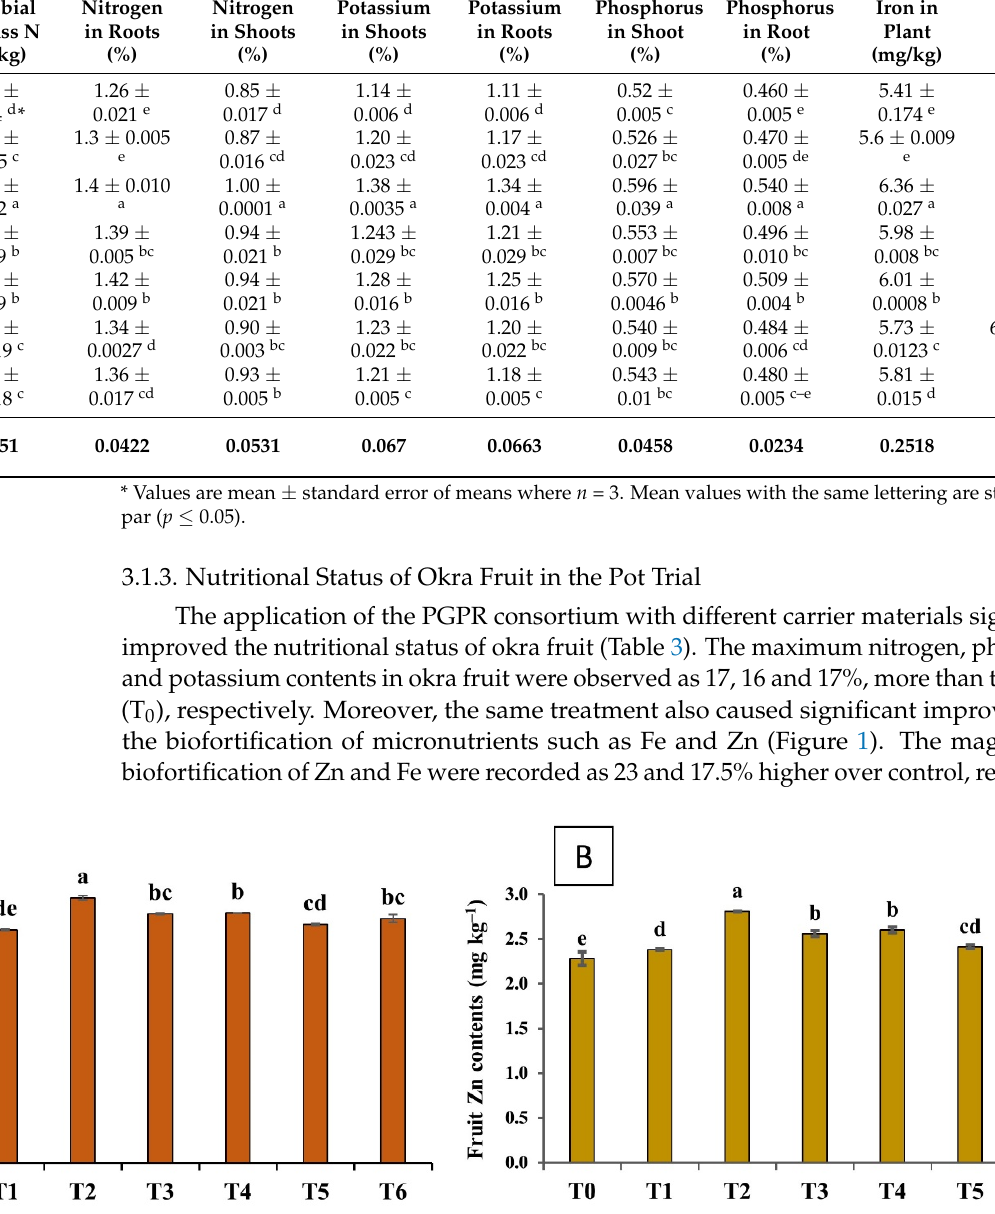
Table 3. Effect of different carrier materials on chemical parameters of okra in pot trial.